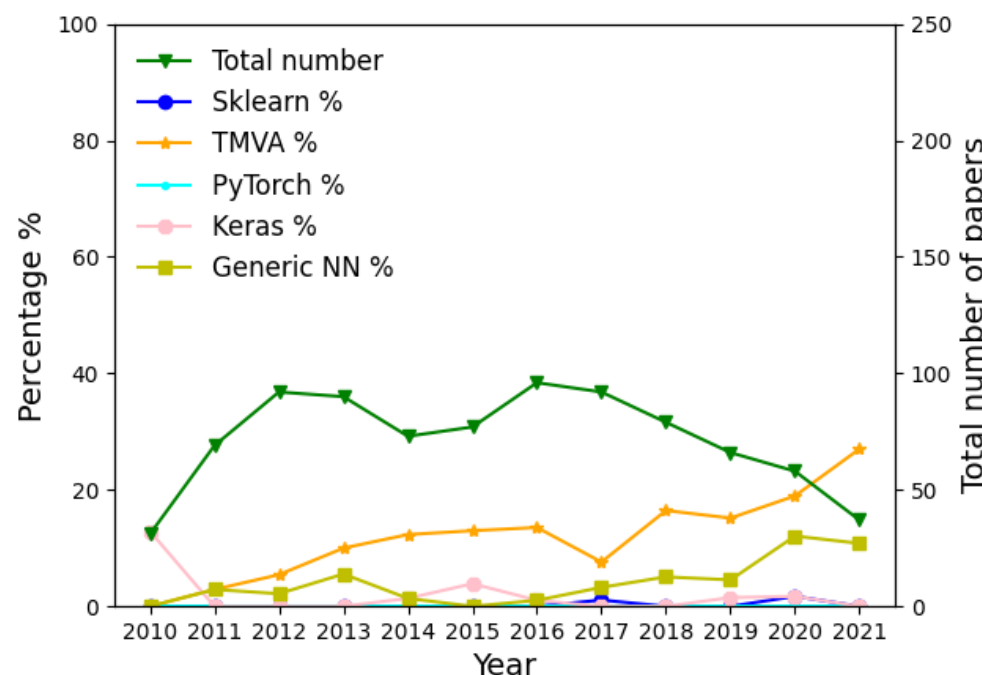
Figure 3. Usage of ML at CMS across the years. We show the number of papers published every year (denoted as “Total number” and corresponding to the right axis), as well as the fraction of them reporting the use of TMVA, Sklearn, Keras, PyTorch and Generic NNs (in the left axis). The latter category corresponds to papers mentioning the use of NNs but never referencing any of the aforementioned